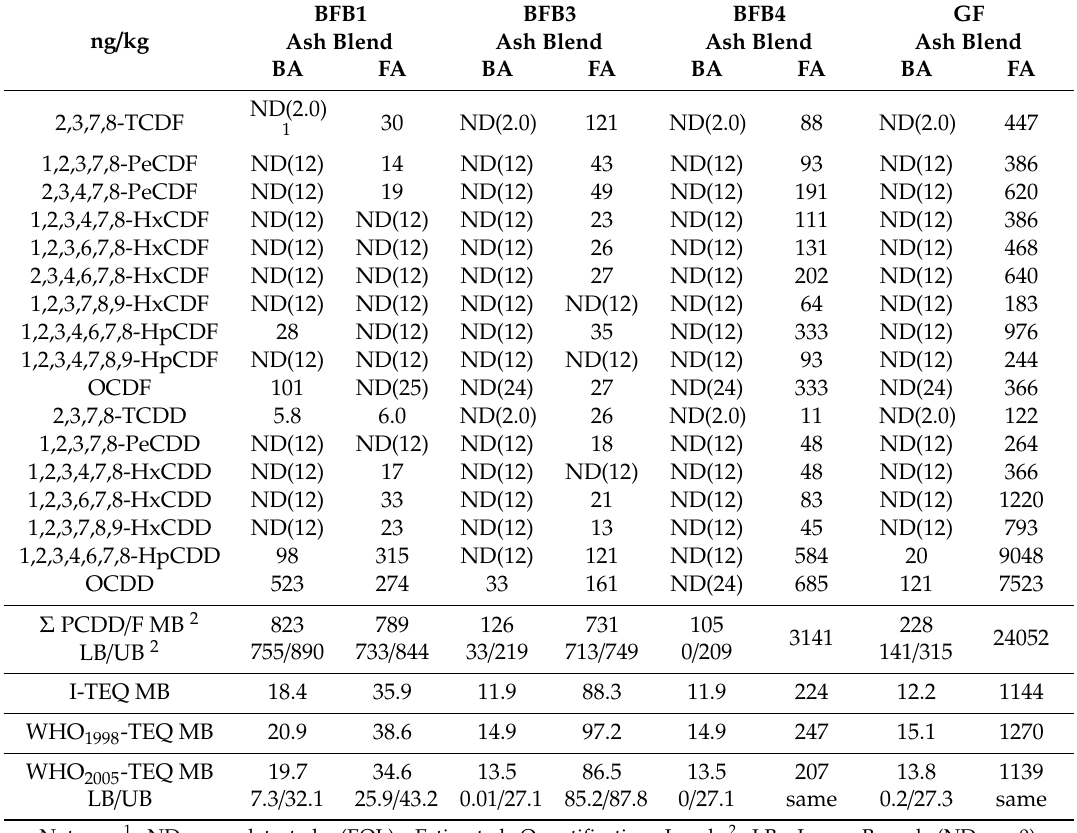
Table 7. PCDD / Fs and TEQs of biomass ash Blends, in dry